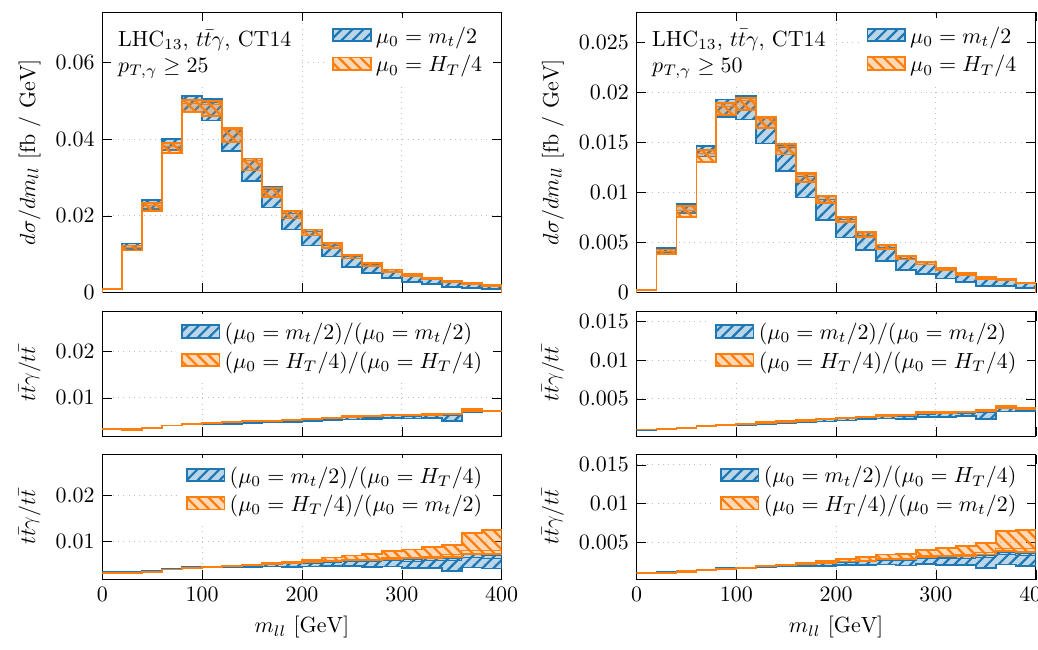
Figure 5 . Di(cid:11)erential cross section distributions as a function of the invariant mass of two charged leptons for the pp e + (cid:23) e (cid:22) (cid:0) (cid:22) (cid:23) (cid:22) b (cid:22) b(cid:13) + X process at the LHC run II with p s = 13 TeV. ! The upper plots show absolute NLO predictions for p T;(cid:13) > 25 GeV (left panel) and p T;(cid:13) > 50 GeV (right panel) together with the corresponding uncertainty bands resulting from scale variations. Renormalisation and factorisation scales are set to the common value (cid:22) R = (cid:22) F = (cid:22) 0 where (cid:22) 0 = m t = 2 and H T = 4. The CT14 PDF set is employed. The lower panels display di(cid:11)erential cross section ratios together with their uncertainty bands. In the (cid:12)rst case (middle panel), the same (cid:12)xed (dynamical) scale choice is employed in the numerator and the denominator of the cross section ratio. In the second case (bottom panel), di(cid:11)erent scale choices in the numerator and in the denominator have been